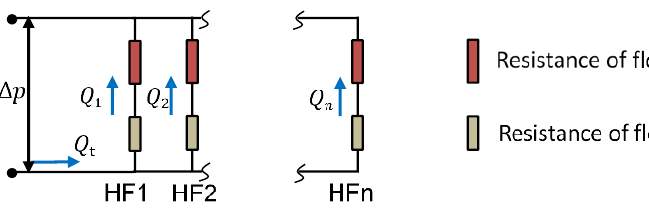
Figure 16. Illustration of the flow distribution mechanism in the system.